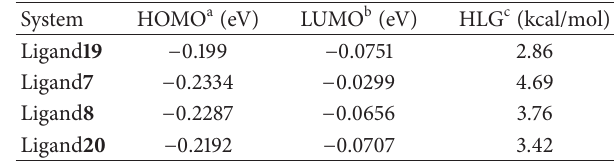
Table 7: Frontier Molecular Orbital Energies of optimized struc- tures of Ligands 19 , 7 , 8 , and 20 at M06/6-31g(d) level in gas phase. HighestOccupiesMolecularOrbital(HOMO) a ,LowestUnoccupied Molecular Orbital (LUMO) b , and HOMO-LUMO gap (HLG) c